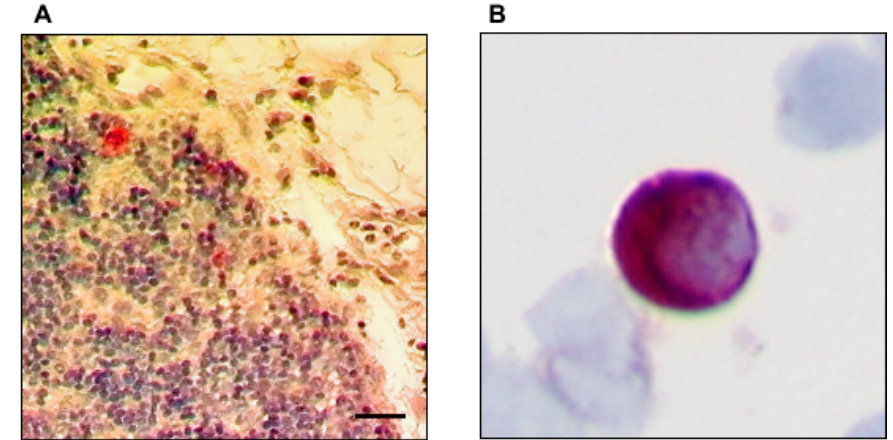
Figure 1. Representative images of the immunohistochemical staining for lymph node micrometastases (LNMM) and bone marrow micrometastases (BNMM). ( A ) Cytokeratin positive cells labeled by AE1/AE3 in the lymph node. Bar indicates 20 µm. ( B ) Cytokeratin positive cells in the bone marrow labeled by A45-B/B3 in 600-fold magnification.